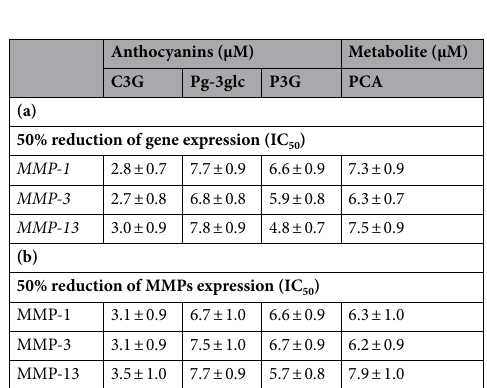
Table 1. Anthocyanins concentration for approximate 50% inhibition of MMPs gene expression (a) and protein expression (b).